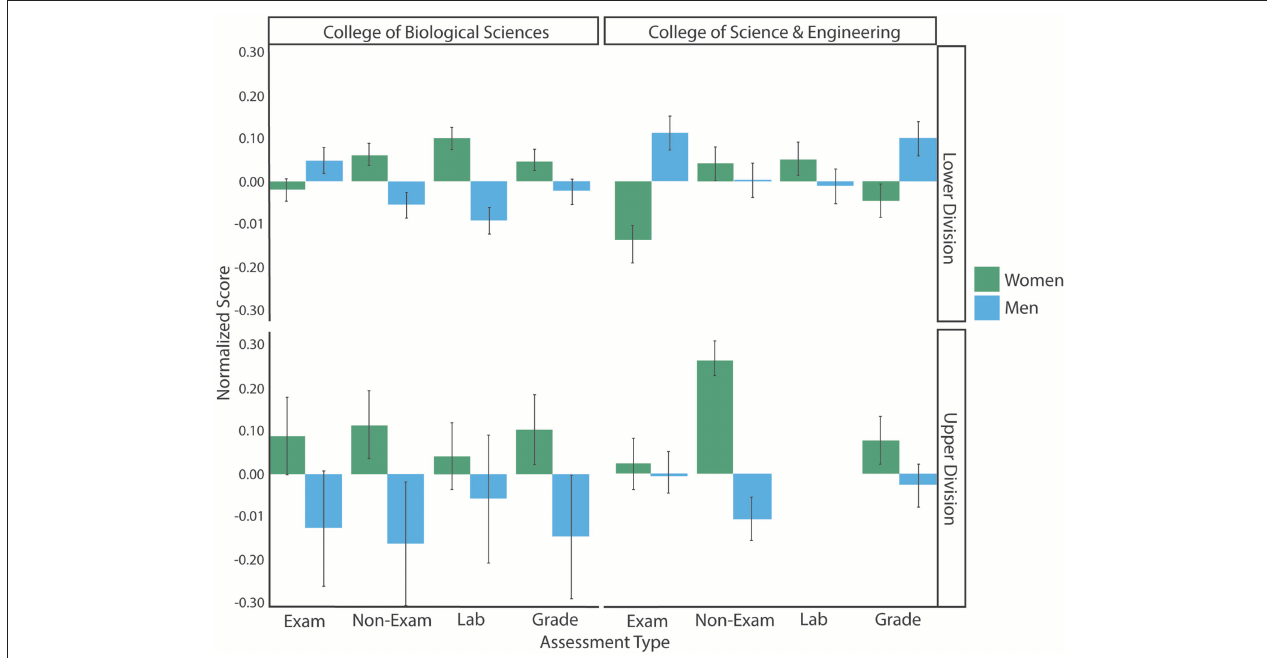
FIGURE 1 | Average normalized performance for women and men across different assessment methods (exam, non-exam assessments, laboratory, and overall course grade), disciplines (College of Biological Sciences, CBS; College of Science and Engineering, CSE), and divisions (lower division or upper division courses).